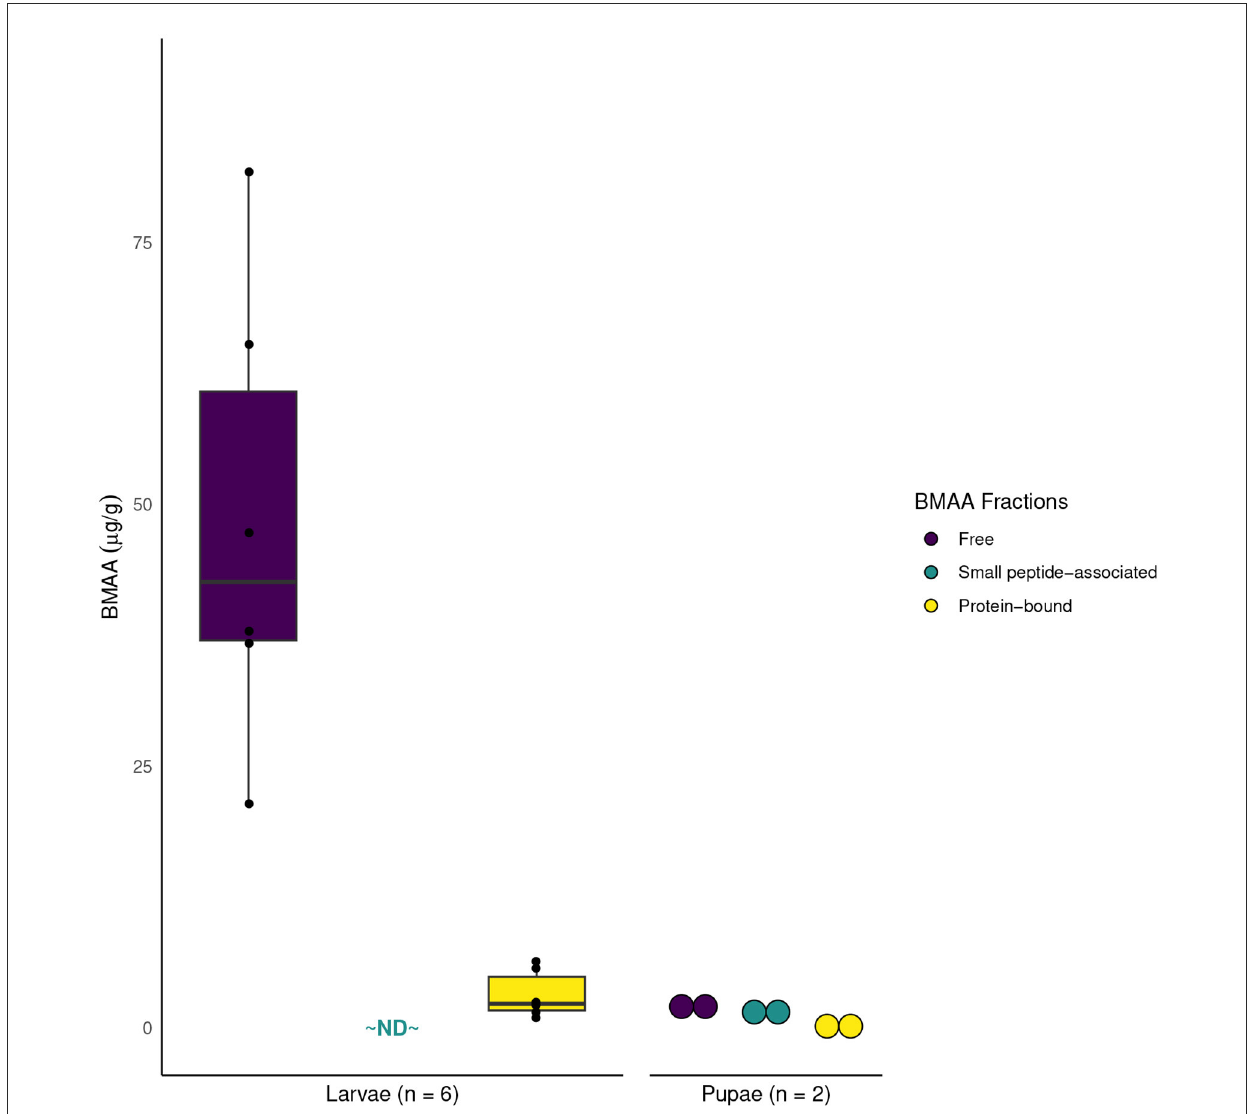
FIGURE3 Separate BMAA fractions were extracted from whole, unpooled Eumaeus atala larvae and pupae in stages to compare quantities of free BMAA, small peptide-associated BMAA, and protein-bound BMAA within the insect tissues. Larvae contained considerably more free BMAA than protein-bound BMAA, and BMAA associated with small peptides was not detected in larvae (ND, not detected). All three forms of BMAA were found in low quantities in pupae.